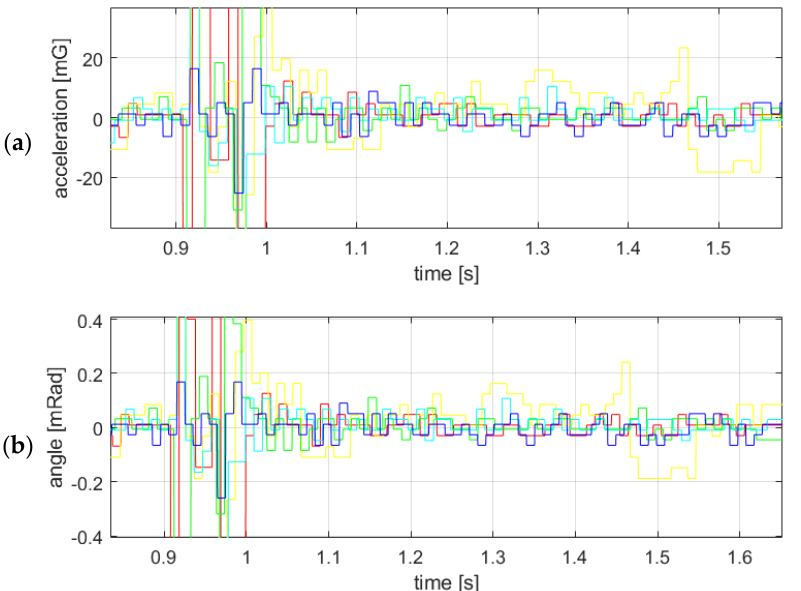
Figure 27. The results of the single impulse test on a larger scale: ( a ) Time–acceleration, ( b ) Time–angle. Material: saclSi 1; Isotropic pressure 20 kPa; Amplitude 8.6 V; Impulse duration 50 ms (– the top sensor, S1, – the second sensor from the top, S2, – the third sensor from the top, S3, – the fourth sensor from the top, S4, – the bottom sensor, S5).